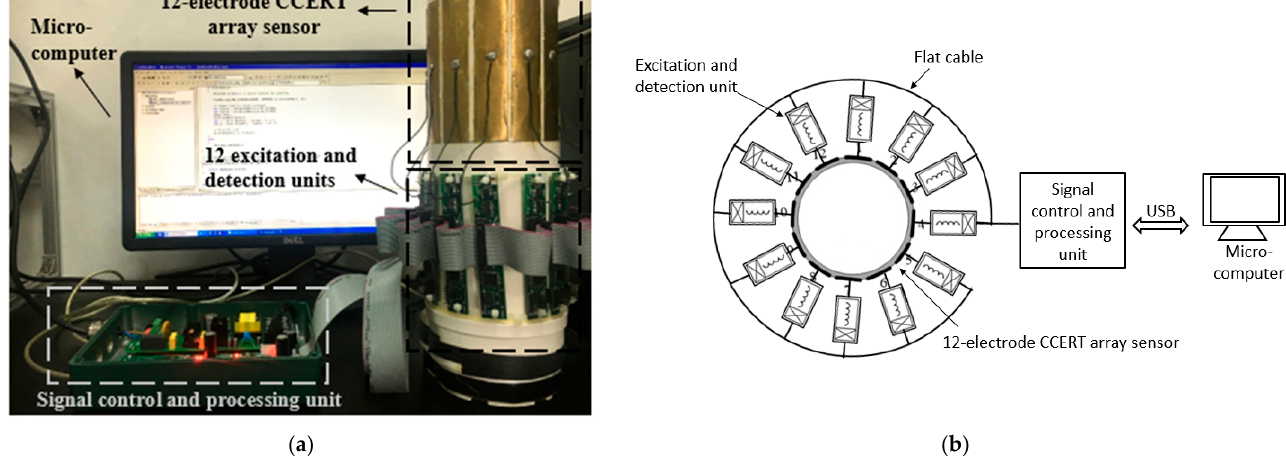
Figure 9. ( a ) A photo of the 12-electrode CCERT (capacitively coupled electrical resistance tomography) system and ( b ) the 12-electrode CCERT system setup. Table 5. Experimental reconstruction results and accuracy analyses.